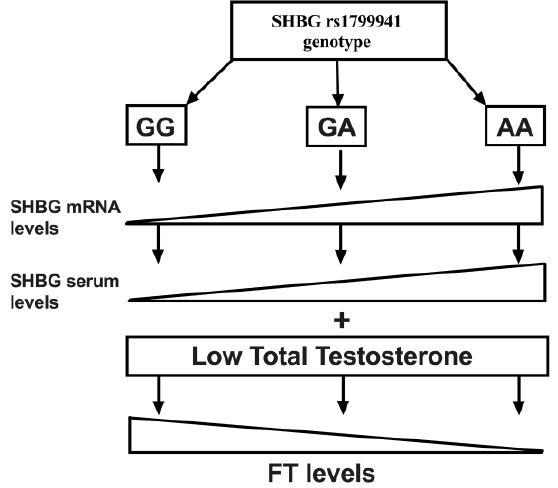
Figure 2. Schematic representation showing the relationship between the genotype of the rs1799941 and the gene and serum expression of SHBG. The presence of the minor allele (A) triggers a higher expression of both mRNA and serum levels of SHBG, which at the same levels of total testosterone (TT) can reduce free testosterone (FT) levels. Thus, the presence of the minor genotype (AA) could hinder FT compensation capacity at a low TT level state.